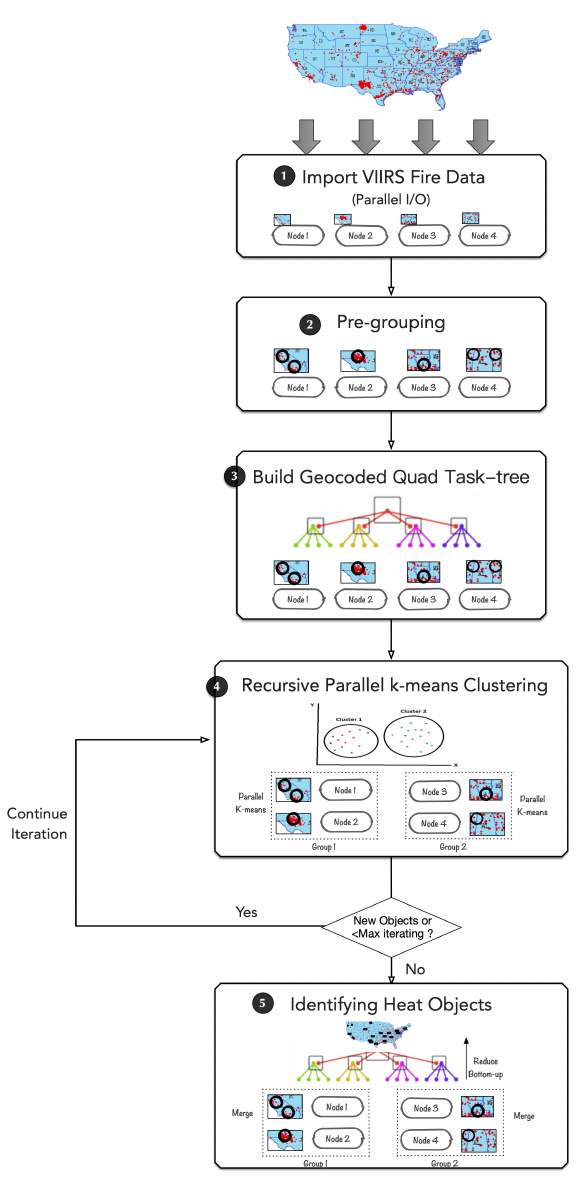
Figure 3. Parallel industrial heat source identification approach for spatial-temporal distribution analysis with a geocoded task-tree-based large-scale